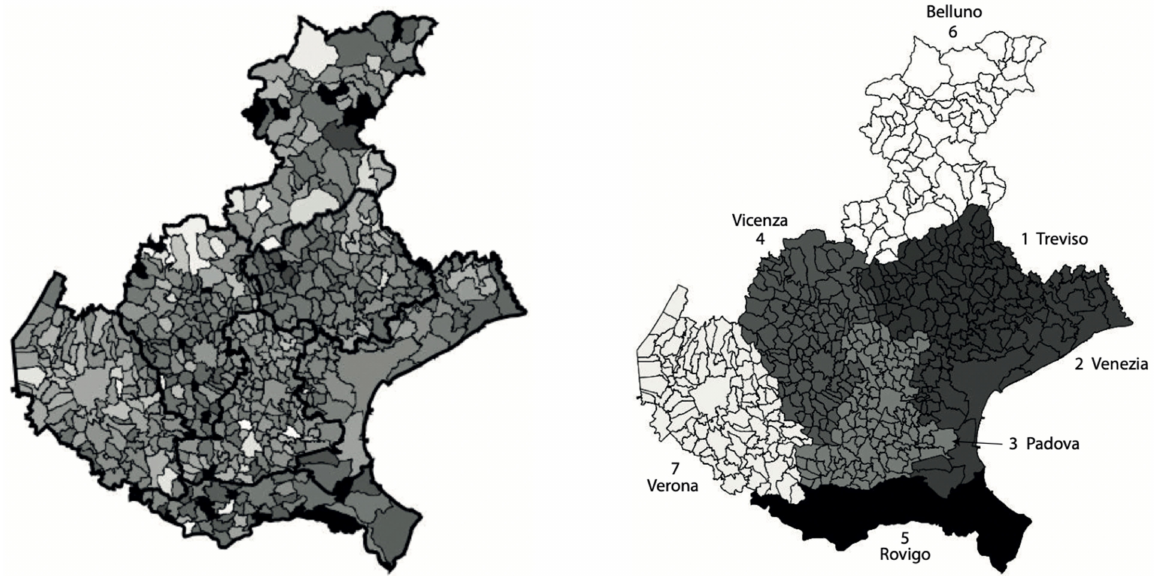
Figure 2. Left: map of the SARS-CoV-2 municipalities incidences in Veneto relative to the period from 12 March to 15 May 2020, normalized by the corresponding populations at 31 December 2019. Intensity increases with respect to the normalized incidence. The intensities of a few municipalities with outlier values of the incidence were rescaled to increase the contrast of the map. The provinces boarders are thicker. Right: map of the Veneto provinces normalized incidences, obtained as the ratio between the sum of the total number of cases in all province municipalities and the corresponding total province population. The populations for the provinces (numbered from 1 to 7) are, respectively: 888,309; 851,663; 939,672; 862,363; 233,386; 201,972;